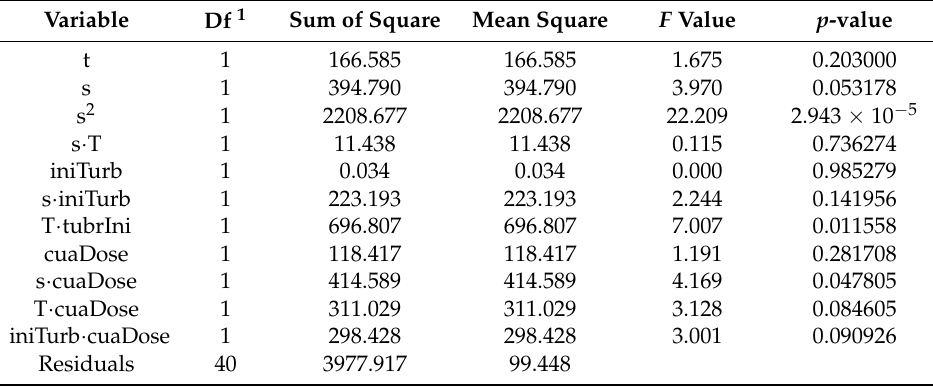
Table 7. ANOVA values for the “finTurb” quadratic model for ECOTAN BIO